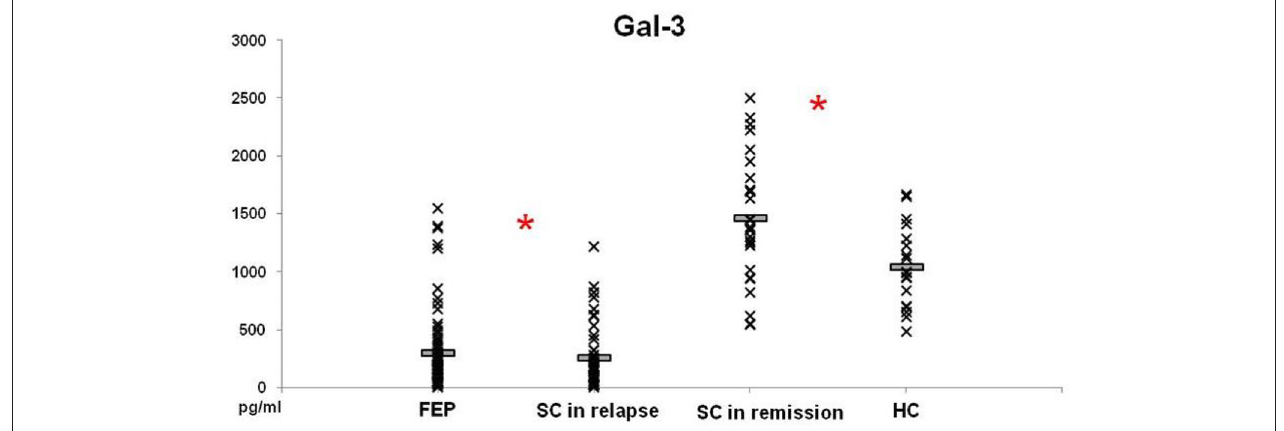
FIGURE 3 | Serum levels of Gal-3 in FEP patients ( n = 77), SC in relapse ( n = 45), SC in remission ( n = 27) and healthy subjects ( n = 18) were determined by ELISA. Data presented as mean ± SE. Statistical significance was tested by Kruskal-Wallis and Mann-Whitney test (* p < 0.05). Serum concentrations of Gal-3 were significantly lower in FEP and SC in relapse groups and higher in SC in remission, compared with group of healthy control